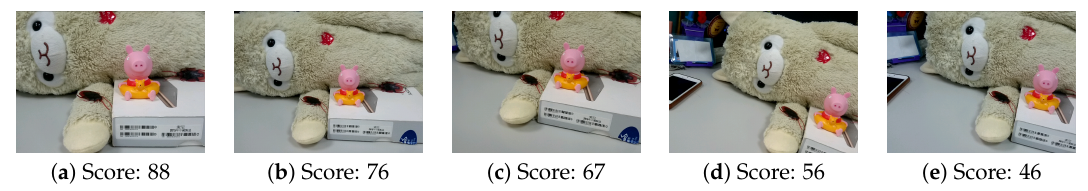
Figure 33. The scores for the first scene using the composition methods of horizontal, rule of thirds, triangle, and focus.